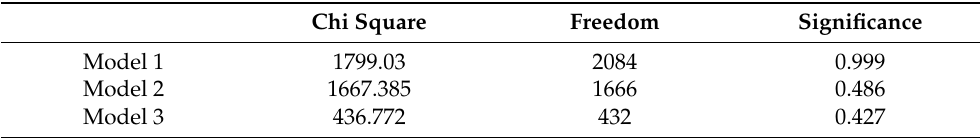
Table 2. Chi-square test.